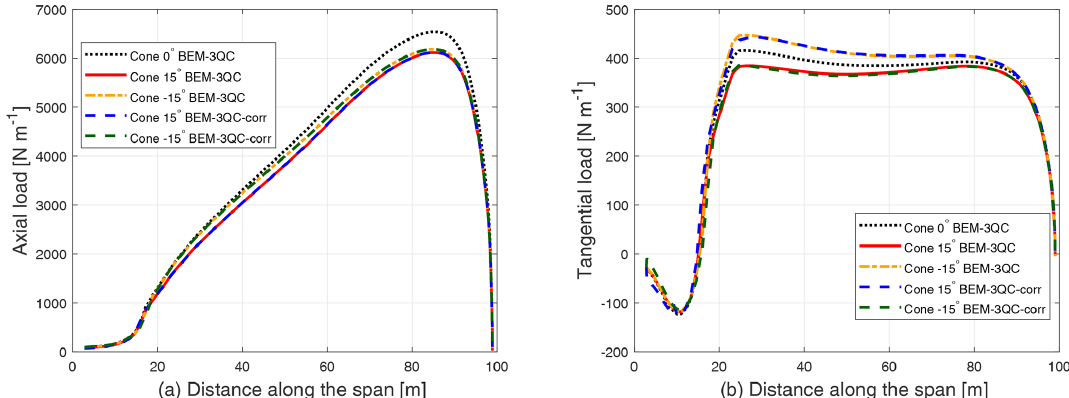
Figure 14. Comparison of axial load (a) and tangential load (b) of the straight blade without coning, with 15 ◦ of upwind coning and with 15 ◦ of downwind coning (labeled as Cone − 15 ◦ ) calculated from the BEM method with and without the one-point lifting-line correction (labeled as BEM-3QC-corr and BEM-3QC). The results of the straight blade without coning are also included for